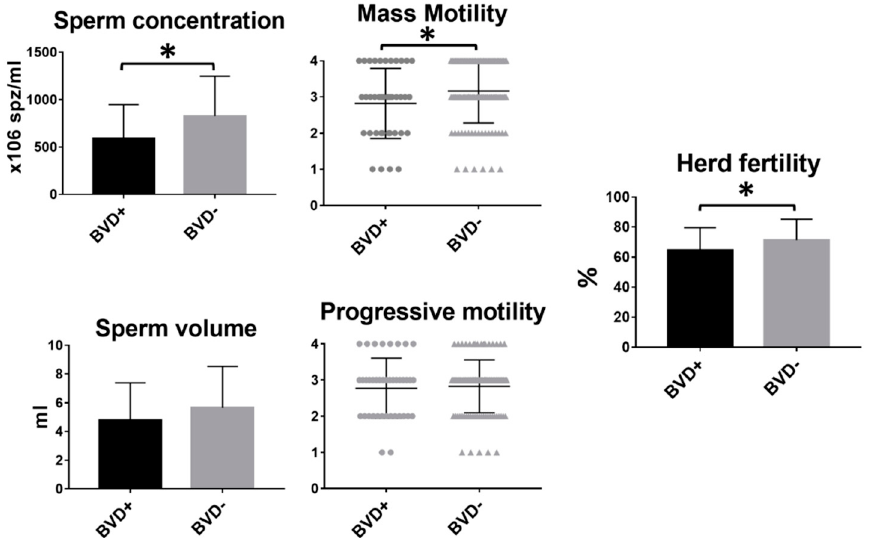
Figure 1. Differences in sperm parameters and fertility between bovine viral diarrhea (BVD)-positive and BVD-negative bulls. Mean and SEM of seminal parameters and herd fertility of BVD-